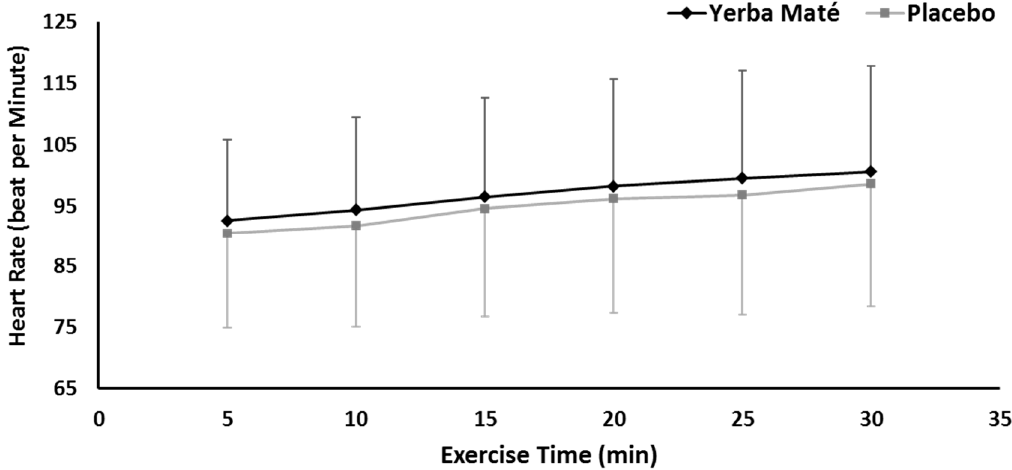
Figure 4. Heart rate response during exercise in Yerba Mate (YM) vs. placebo (PLC).